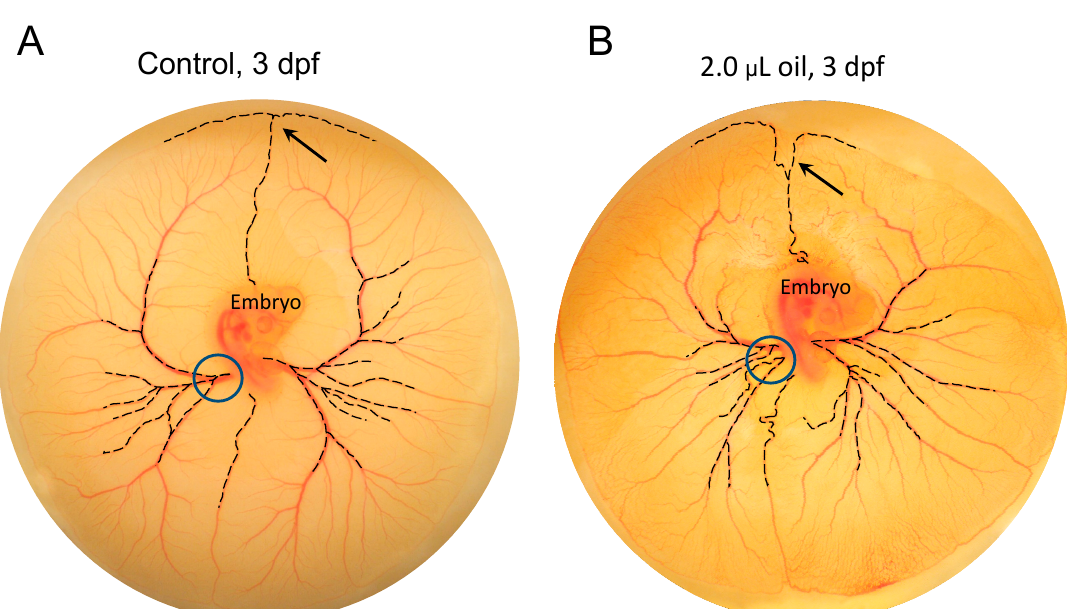
3 ‐ day ‐ old chicken embryo. ( A ) A sample image of the CAM of a 3 ‐ day ‐ old embryo grown ex ovo. ( B ) CAM vasculature evident in a digitally enhanced image. ( C ) Pathway of the CAM vessels (red lines) and branch points (blue dots). Images in ( B ) and ( C ) were analyzed using the AngioTool ImageJ plugin. ( D ) Vascular tree topology reconstructed from microscopic images [60] . See text for further details.